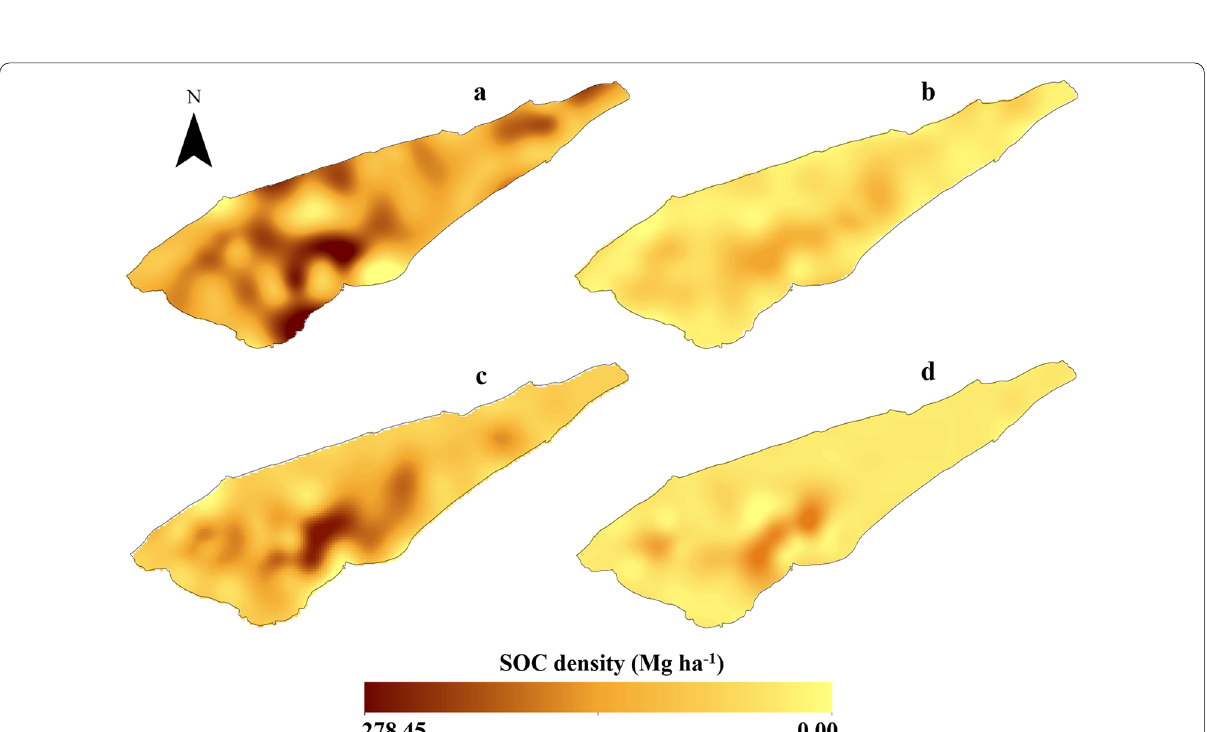
Fig. 3 Distribution of SOC densities at different core-depth intervals. a D1 (0–20 cm); b D2 (20–40 cm); D3: (40–70 cm); D4: (70–100 cm)